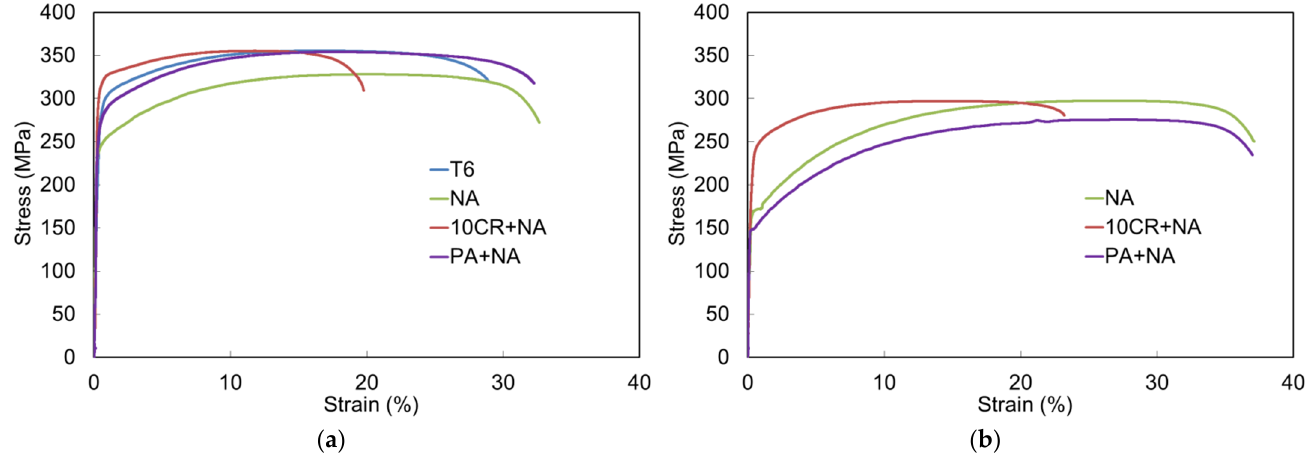
Figure 7. Tensile properties of ( a ) T6, NA, 10CR + NA and PA + NA samples aged artificially for 10.8 ks and ( b ) NA, 10CR + NA and PA + NA without artificial aging. 10.8 ks and ( b ) NA, 10CR + NA and PA + NA without artificial